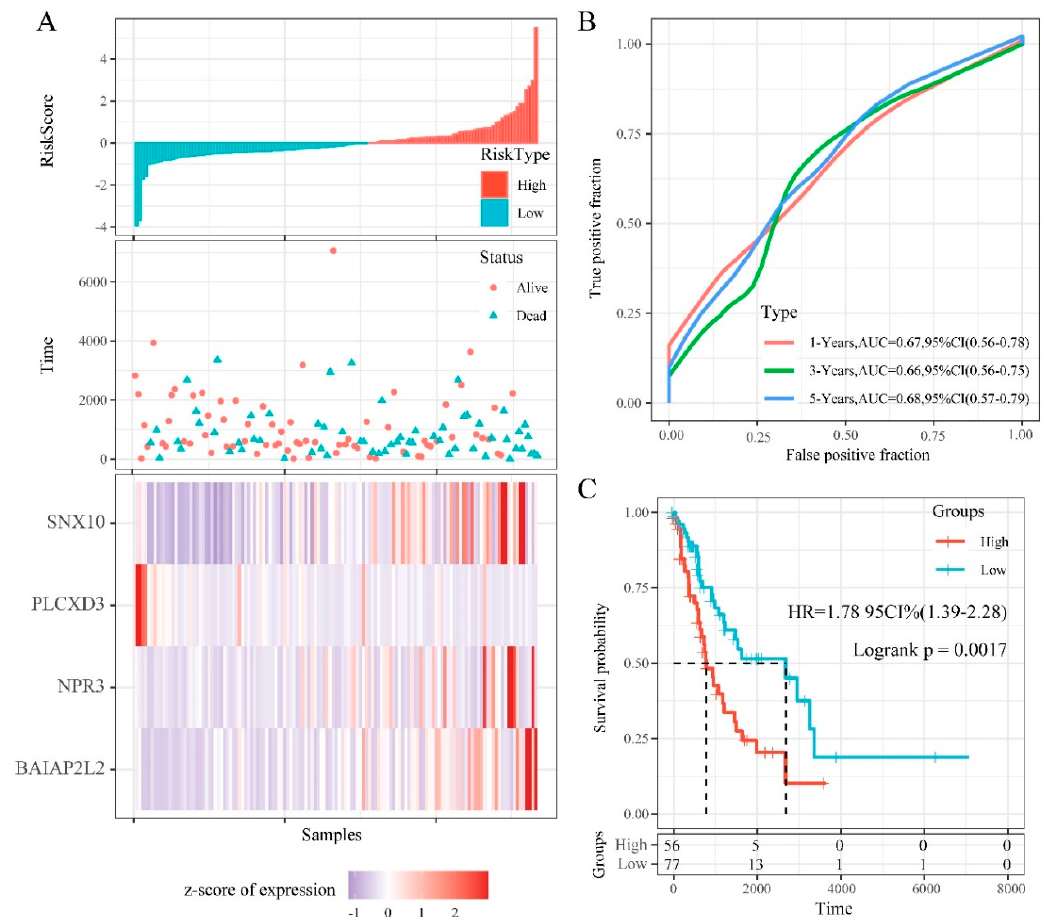
Figure 8. The relationship between RiskScore and patient outcome in the training cohort (from the Cancer Genome Atlas (TCGA)). ( A ) Each patient’s RiskScore, survival time, and status, and the expression of 4 DMEGs. The horizontal axis represents the samples, and the vertical axis represents RiskScores, OS (overall survival), and immune-related gene expression, respectively. ( B ) 1-, 3-, and 5-years ROC analysis of prognosis classification for RiskScore. ( C ) KM survival analysis of patients with high RiskScore vs. low RiskScore.